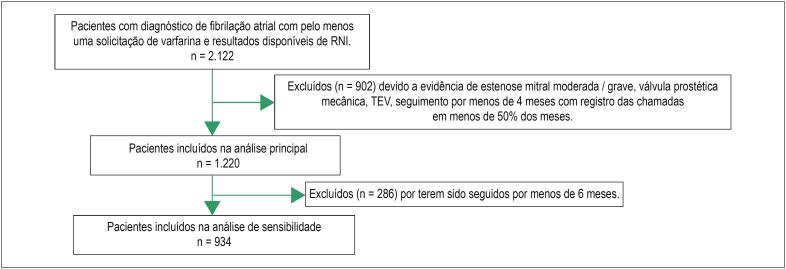
Fluxograma descrevendo os critérios de inclusão e exclusão.